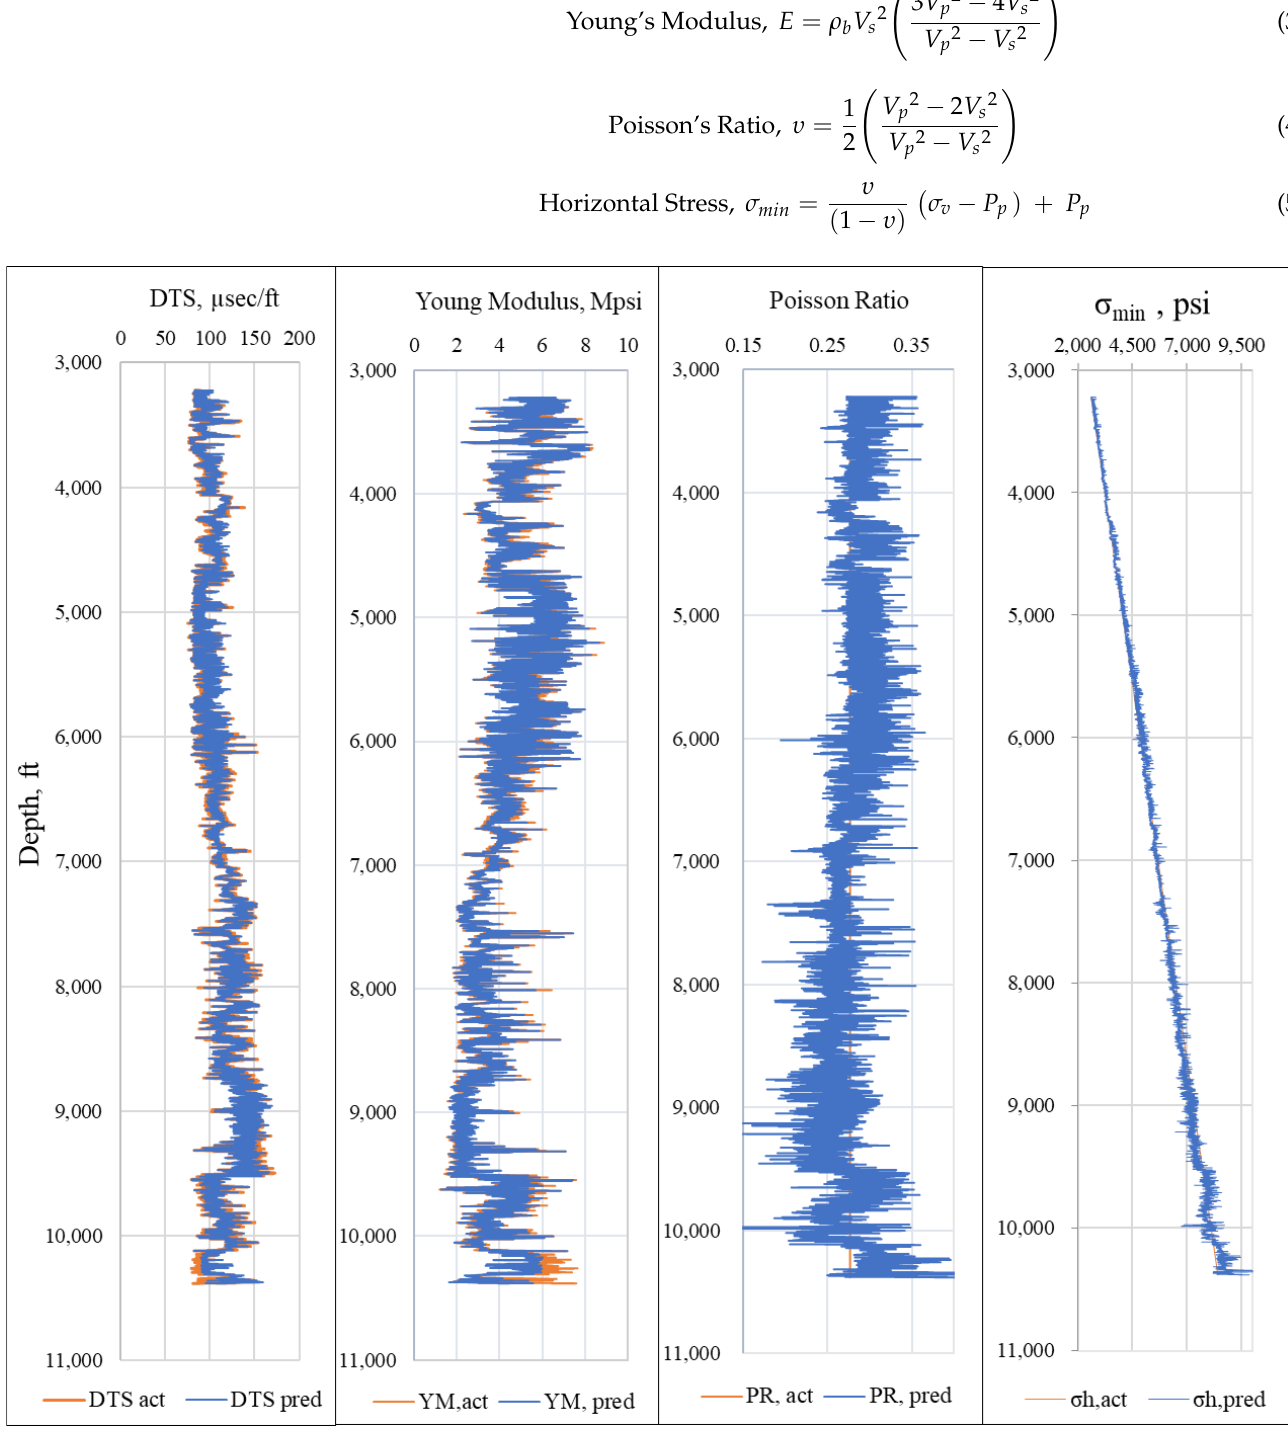
Figure 18. Estimation of geomechanical properties from predicted DTS for P1 well.